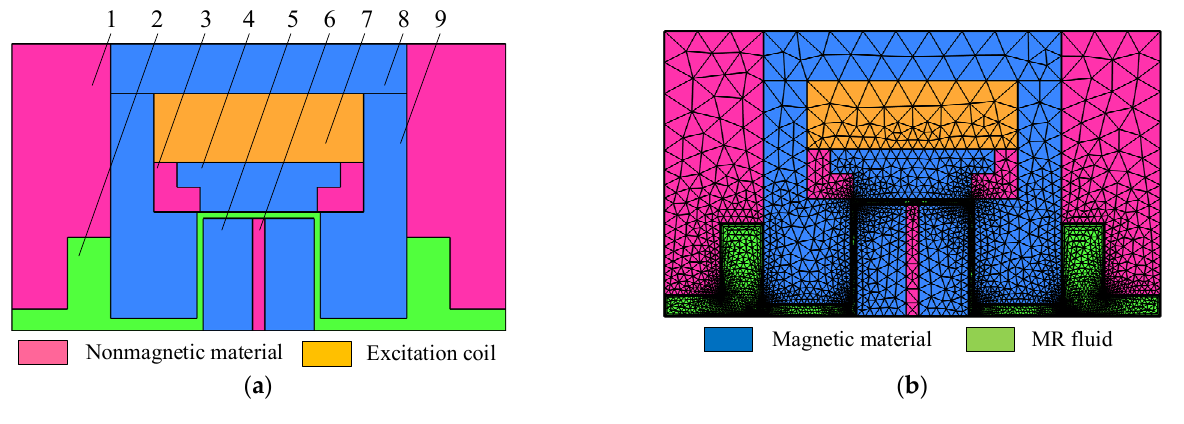
Figure 2. A 2D finite element model of the MR valve: ( a ) entity model, ( b ) meshed model. 1. End cover, 2. MR fluid, 3. Nonmagnetic ring, 4. Magnetic ring, 5. Damping disk, 6. Nonmagnetic disk, 7. Excitation coil, 8. Valve body, 9. Positioning plate.